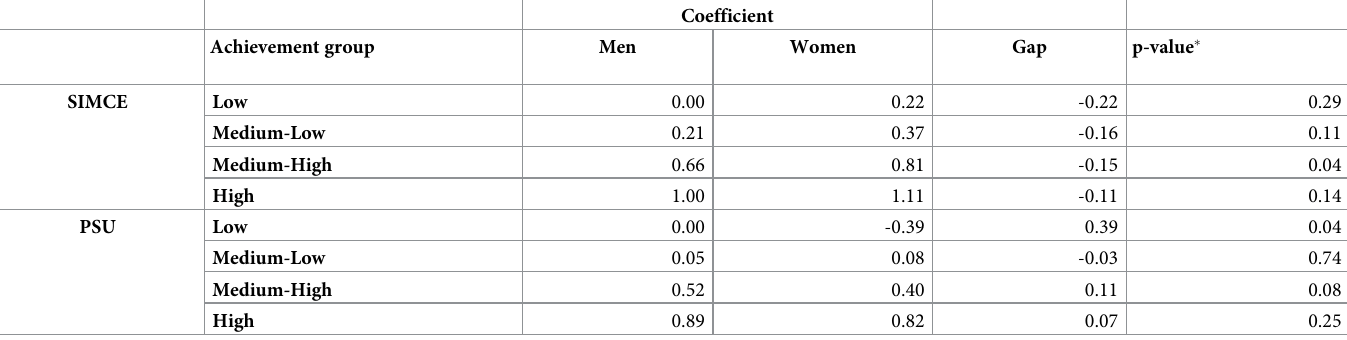
Table 7. Gender gaps comparison for different levels of previous achievement. Estimations based on Model (3) for